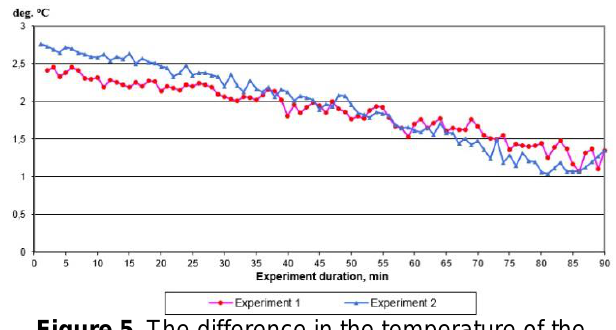
Figure 5. The difference in the temperature of the working fluid as it passes through the flow part of the HDH in the first series of experiments without maintaining the preset pressure at the pump unit rotation speed of 100%